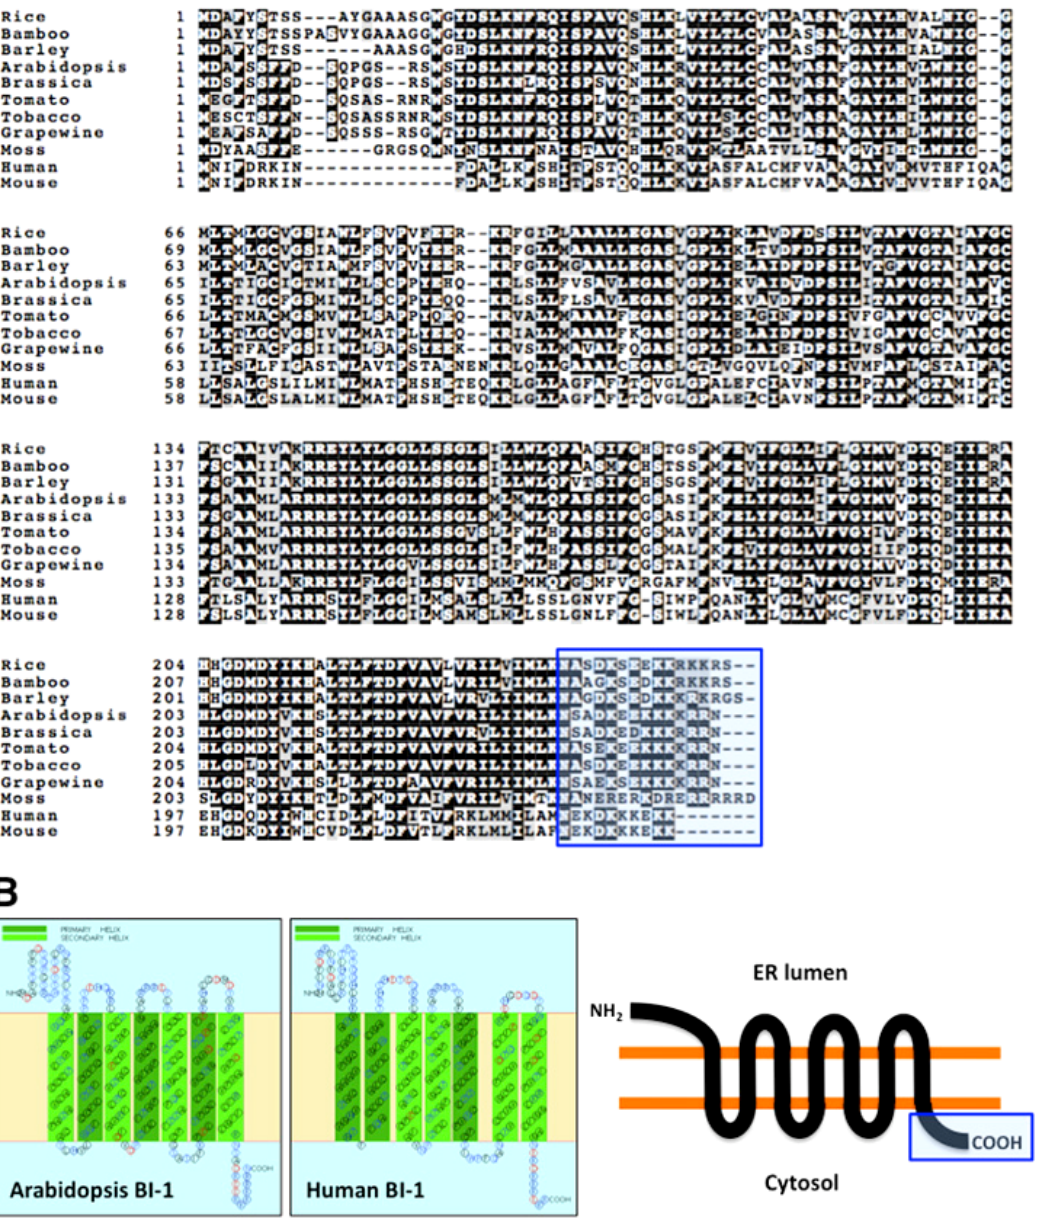
Figure 1. Sequence analysis of BI-1 from plants and